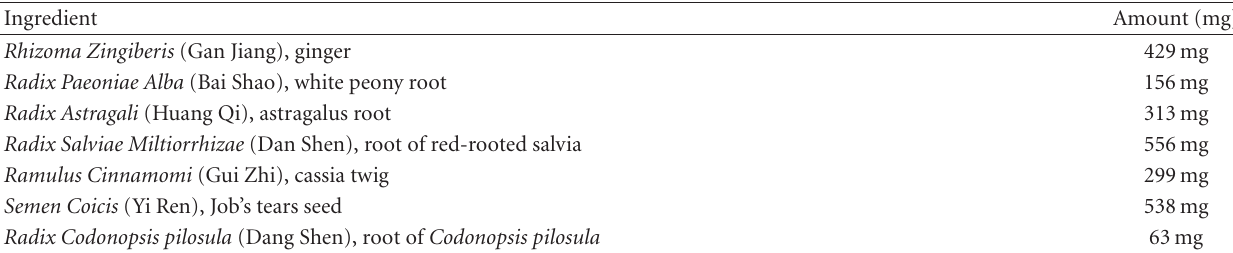
Table 1: Herose Psoria capsule ∗